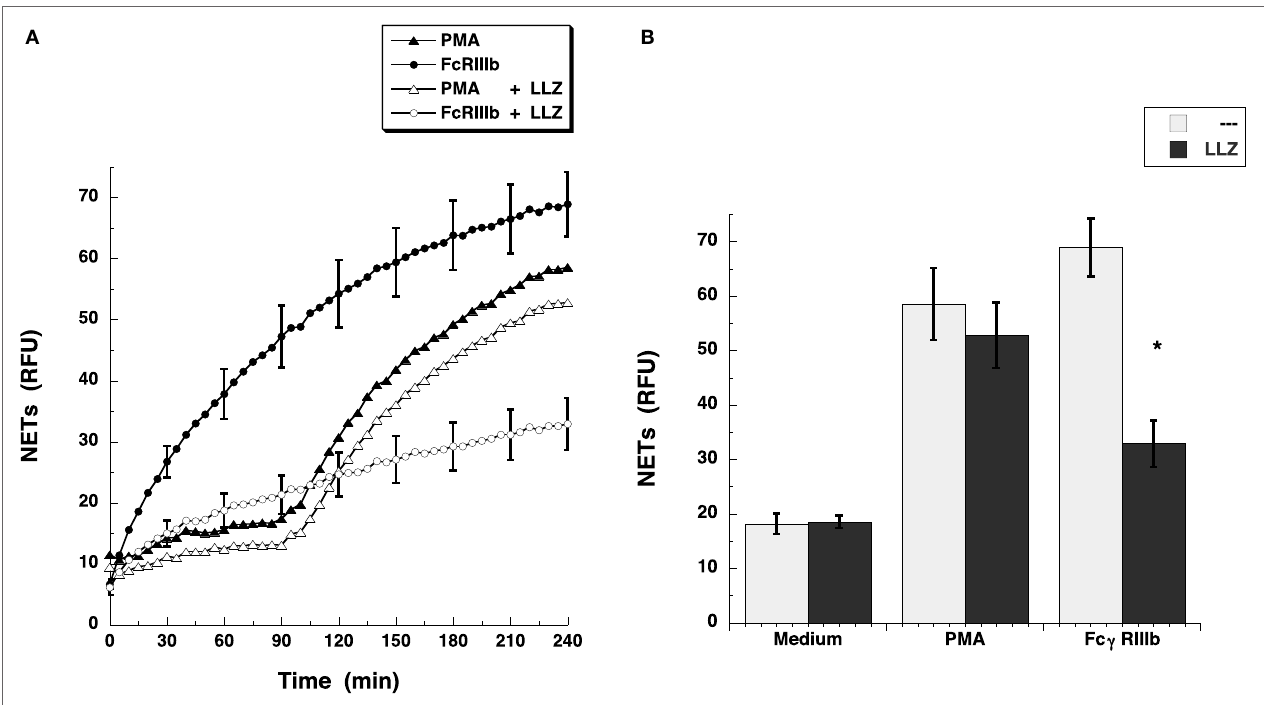
FigUre 2 | TaK1 is required for Fc γ riiib-induced neT formation . (a) human neutrophils were stimulated with 20 nM phorbol 12-myristate 13-acetate (PMA), or by cross-linking Fc γ RIIIb with mAb 3G8, and then incubated for 4 h. Some neutrophils were previously treated with 10 nM LL Z1640-2 (LLZ), a selective inhibitor of TAK1 (white symbols), or with only the solvent (DMSO) (black symbols). The relative amount of NETs was estimated from SYTOX ® Green fluorescence in relative fluorescent units (RFU) every 5 min. Data are mean ± SEM of three experiments done in tetraplicates. (B) human neutrophils were previously treated with solvent alone (---) or with the 10 nM LL Z1640-2 (LLZ), before stimulating with nothing (medium), 20 nM PMA, or by cross-linking Fc γ RIIIb, and then incubated for 4 h. The relative amount of NETs was estimated from SYTOX ® Green fluorescence in relative fluorescent units (RFU) at 4 h after stimulation. Data are mean ± SEM of three experiments done in tetraplicates. Asterisks denote conditions that are statistically different from control ( p <